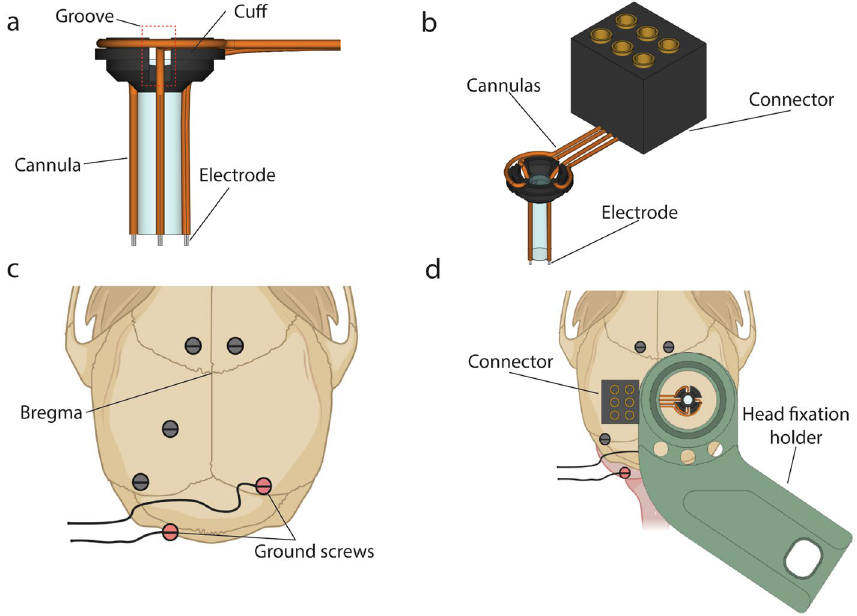
Figure 3. GRIN lens-stainless wire electrode assembly and its implantation on the mouse skull, used for Fig. 4. ( a ) Side view of a lens-electrode assembly ( b ) The lens-electrode assembly with a connector. ( c ) Positioning of screws and ground screws on the mouse skull. ( d ) Position of lens-electrode assembly and head fixation holder over the mouse